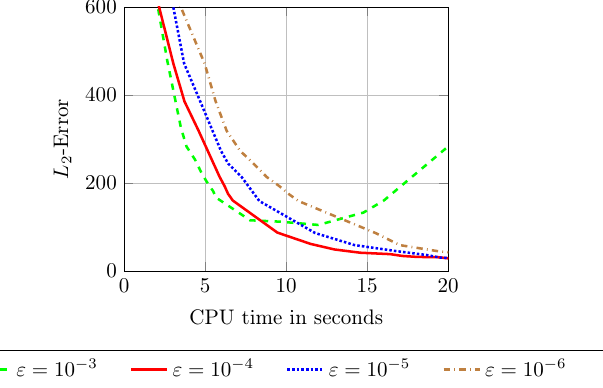
Figure 5. Results of the two-dimensional GES experiment without source: comparison of the L 2 -error and the corresponding CPU time for iterative CN using the CG method and different values ε at t F = 2.609 10 6 for h = 0.04. The reference solution is computed with the EE method. The choice × ε = 10 − 4 provides the best trade-off.